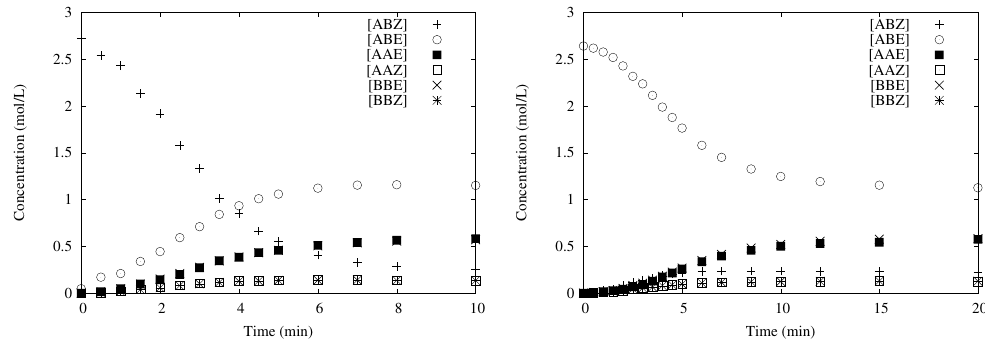
Figure 2. Transformation of methyl oleate with HG-II catalyst at 40 ◦ C, [Ru] = 1.4 × 10 − 5 mol/L, [AB] = 2.7 mol/L: (Left) starting from the Z -isomer; and (Right) starting from the E